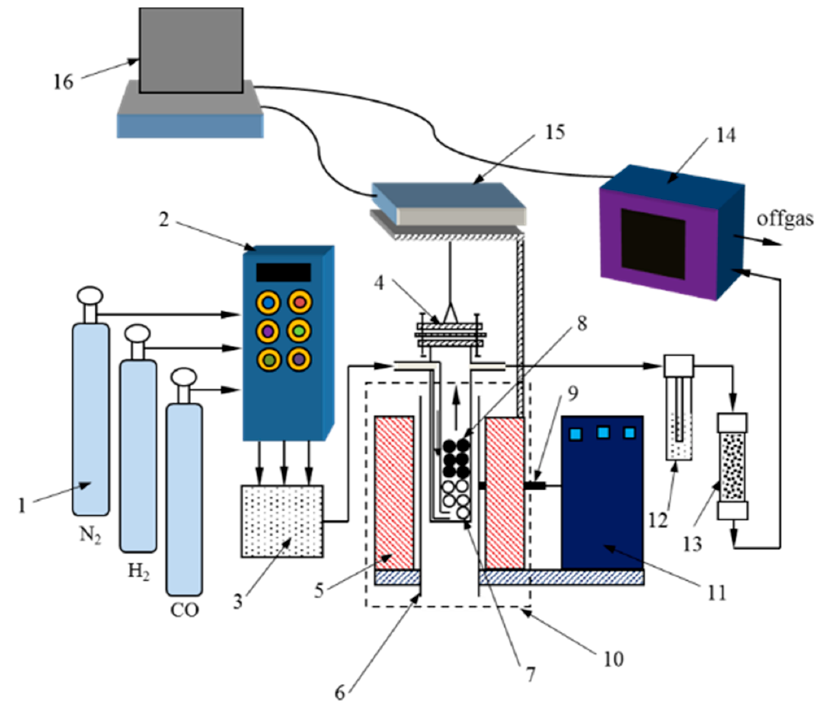
Figure 2. Schematic of the experimental apparatus: 1—gas cylinder, 2—flow control cabinet, 3—gas